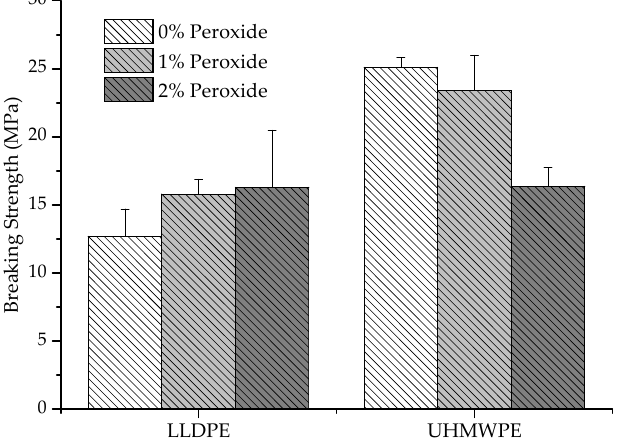
Figure 4. Typical strain versus stress curves for ( a ) LLDPE and ( b ) UHMWPE with the addition of 1% and 2% by mass peroxide.